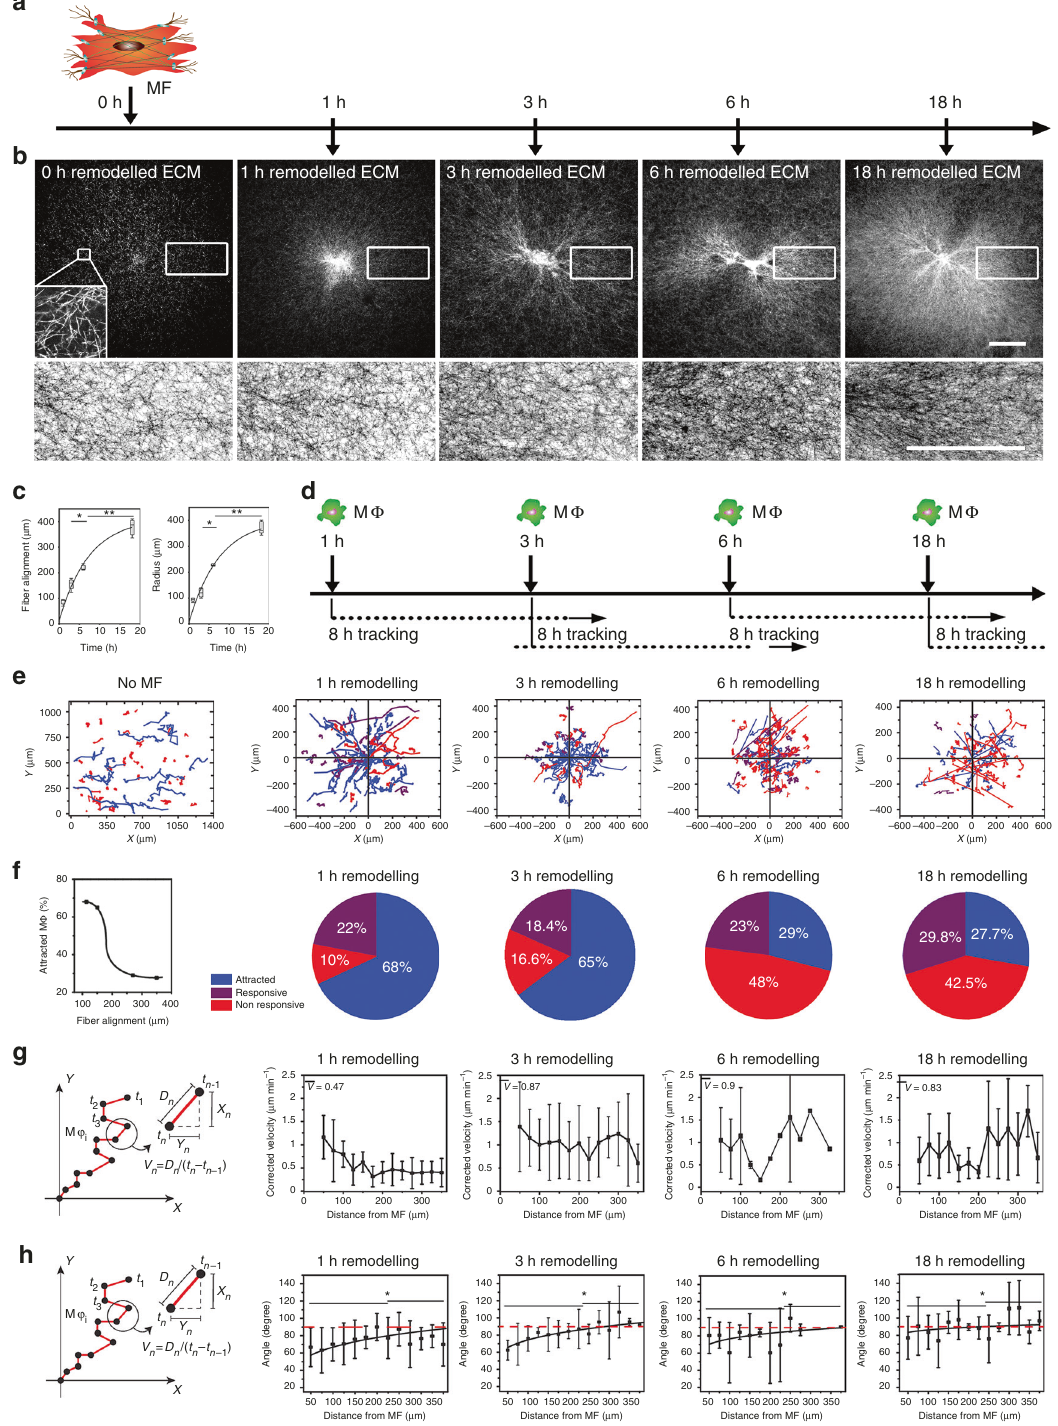
Fig. 4 Structural cues in collagen networks do not enhance macrophage (M ϕ ) migration to myo fi broblasts (MFs). a MFs remodeled collagen extracellular matrix (ECM) for 1 – 18h. b Confocal re fl ection microscopic images were taken of collagen ECM, remodeled by MF (in image center) after 1, 3, 6, and 18h; higher magni fi cations of the boxed regions are shown inverted to highlight fi brillar collagen. c Collagen fi ber alignment and radius of the structural changes in the ECM were calculated and plotted over time of MF remodeling. Data points are averages±SD (** p ≤ 0.01 using analysis of variance followed by post hoc Tukey ’ s multiple comparison test). d MFs were allowed to remodel collagen ECM for 1 – 18h prior to adding M ϕ that were then tracked for another 8h. e Trajectories of migratory M ϕ are plotted with respect of the MF position as a function of pre-remodeling time. f Percentages of attracted, responsive, and non-responsive M ϕ are shown for the different ECM remodeling states (pie charts) and the percentage of attracted M ϕ was plotted as a function of collagen fi ber alignment calculated from confocal re fl ectance images. g Local M ϕ migration velocities, corrected for ECM dragging, were plotted as a function of distance to the MF for every pre-remodeling condition. h Migration angles were plotted as a function of distance to the MF. Data points are medians with error bars representing minima and maxima (93 M ϕ , 20 independent experiments). Slope changes were considered signi fi cant at * p ≤ 0.05, using slope comparison test. All scale bars: 100 µ